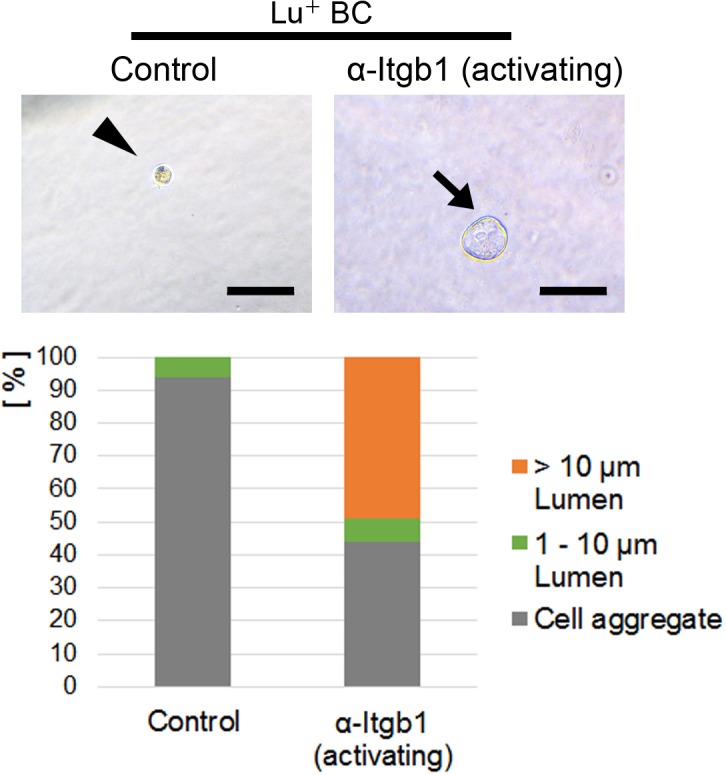
Cyst formation assay of Lu+ BC in the presence of activating anti-Itgb1 antibody (TS2/16) or control IgM.Representative images of cultured Lu+ BC at culture day 6 are shown. Arrow and arrowhead point to a cyst and a cell aggregate, respectively. The details of formed cysts are shown below. The cell cluster devoid of luminal structure was regarded as ‘Cell aggregate’. Scale bar: 100 μm.10.7554/eLife.36572.022Figure 5—figure supplement 4—source data 1.Numerical data for the details of formed cyst in the 3D culture using Lu+ BC in the presence or absence of activating anti-Itgb1 antibody (TS2/16).